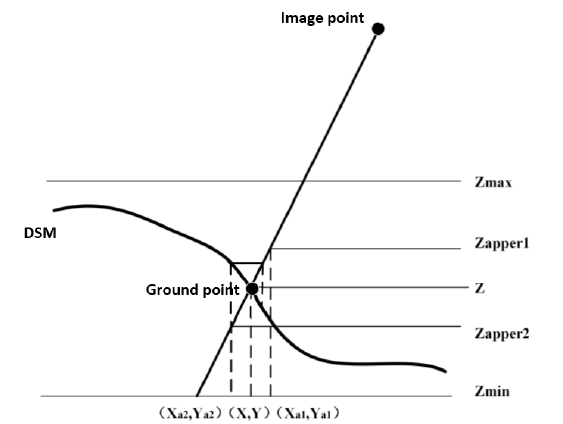
Figure 3. Schematic diagram of laser geometric positioning of single footprint image assisted by DSM 1) Setting the maximum elevation and minimum elevation range according to reference DSM. Assuming the average elevation be zappr1, we can get horizontal coordinates (X a1 , Y a1 ) by the intersection of ray equation with an elevation plane zappr1. 2) Interpolating the horizontal coordinates (X a1 , Y a1 ) into DSM, then new elevation plane Zappr2 is generated . 3) Repeatedly, new horizontal coordinates (X a2 , Y a2 ) can got by intersecting zappr2 and ray equation. Then, the next elevation plane is obtained by interpolation with DSM. 4) The geographic location (X, Y, Z) of the laser point can be obtained by iterative estimation.